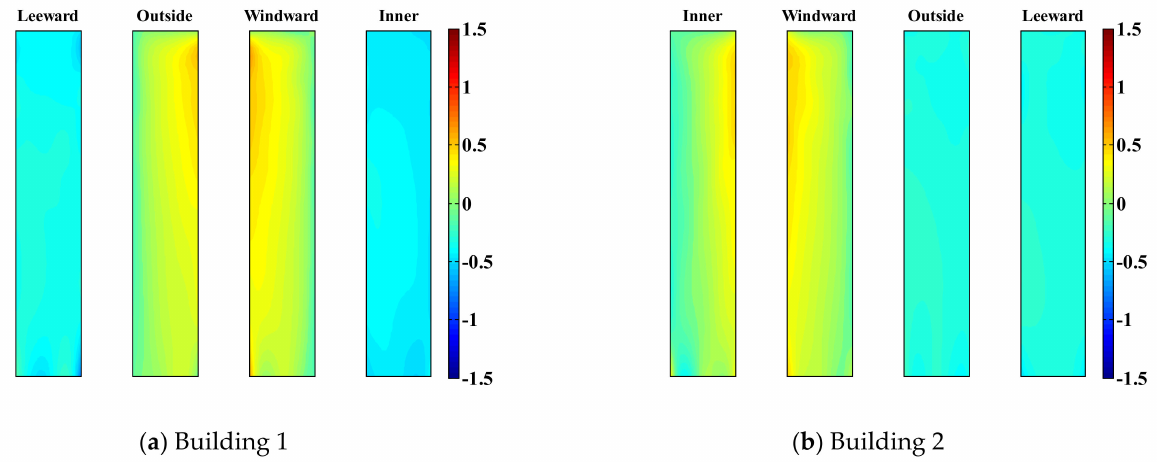
Figure 10. Mean pressure distributions of two buildings with a large gap distance.